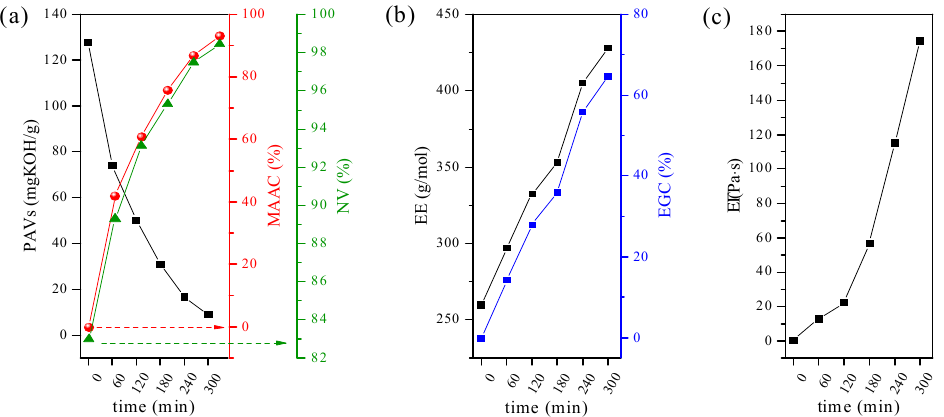
Figure 2. ( a ) The partial acid value (PAVs) vs. methacrylic acid conversion (MAAC) and non- volatile-matter content (NV); ( b ) epoxy equivalent (EE) vs. epoxy group conversion (EGC) and ( c ) viscosity ( η ) as a function of reaction time.